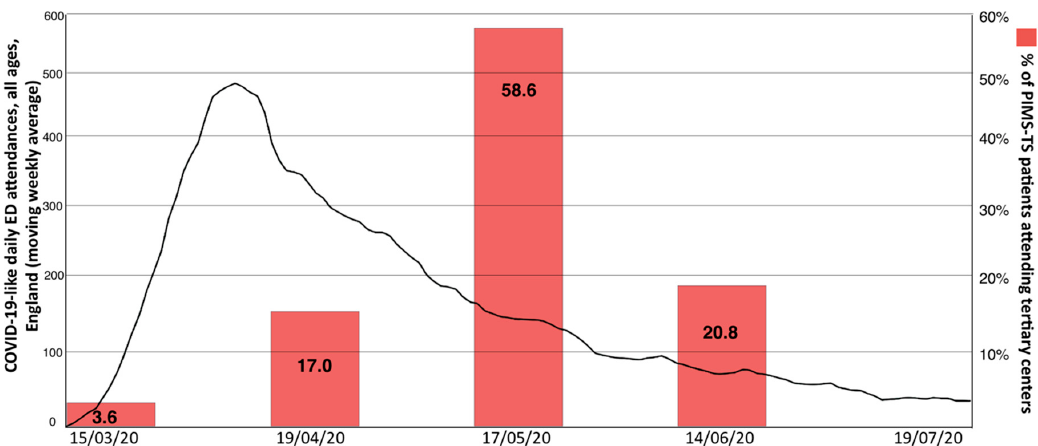
Figure 1. Temporal distribution of paediatric inflammatory multisystem syndrome temporally associated with Severe Acute Respiratory Syndrome Coronavirus 2 (SARS-CoV-2) (PIMS-TS) cases of this cohort, in relation to COVID-19 like presentations to hospitals in England. The peak of presentations of children with paediatric inflammatory multisystem syndrome temporally associated with SARS-CoV-2 followed the peak of presentations of patients, adult and paediatric, to English Emergency Departments, with a lag of 4–6 weeks (Figure adapted from https://www.gov.uk/government/news/weekly-covid-19-surveillance-report-published; week 30). Two-thirds of paediatric patients admitted with PIMS-TS (20/29; 69%) were male. Twelve children were Caucasian (41.4%), 6/29 (20.7%) South East Asian, 2 (6.9%) East Asian, 4/29 (13.8%) African/Caribbean and 5 (17.2%) of unknown or multi-ethnic background. In keeping with other